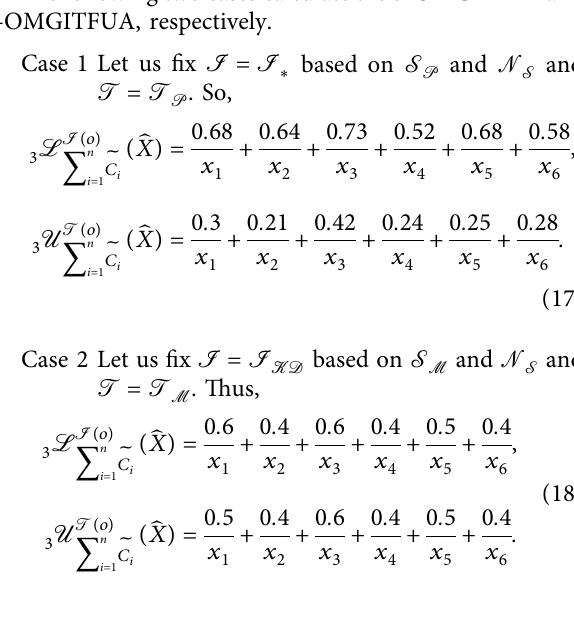
Table 7: Table for 􏽥 N 0 . 5 x 1